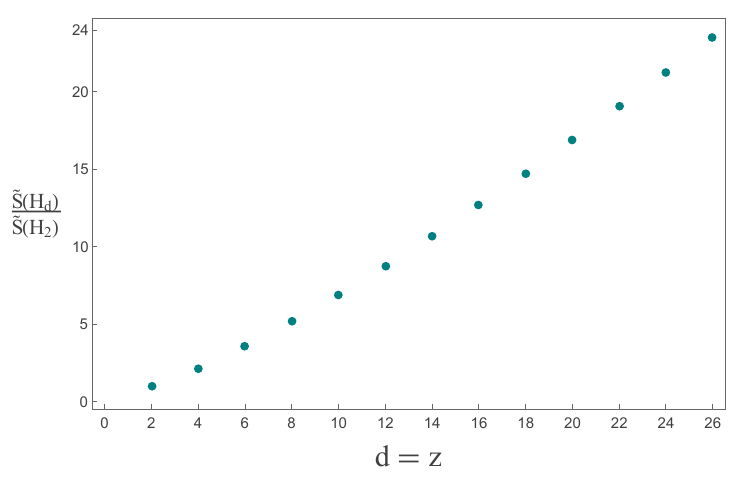
Figure 3 . The universal (cid:12)nite term (4.12) in the entanglement entropy of GQLM on a hemisphere plotted against the number of spatial dimension d (which is equal to the critical exponent z ). We normalise S [ H d ] with respect to the two-dimensional case, and set g = R c = 1. and more values are plotted in (cid:12)gure 3. The two-dimensional case agrees with the result presented in [27]. Notice that the logarithmic term depends on the product R is independent of rescaling of the (cid:12)elds. Hence, in the case of a d -sphere cut into two d -hemispheres, the (cid:12)nite universal terms of the entanglement entropy (4.12) are constant, they only depend on the physical compacti(cid:12)cation radius R appears in the above expression through the zero